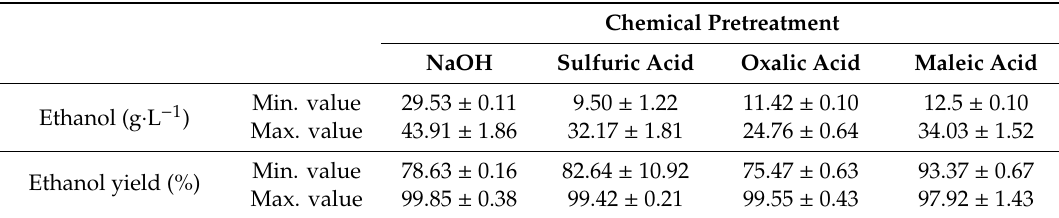
Table 3. Summary of ethanol produced by fermentation of pretreated SCB hydrolysate for the di ff erent pretreatment